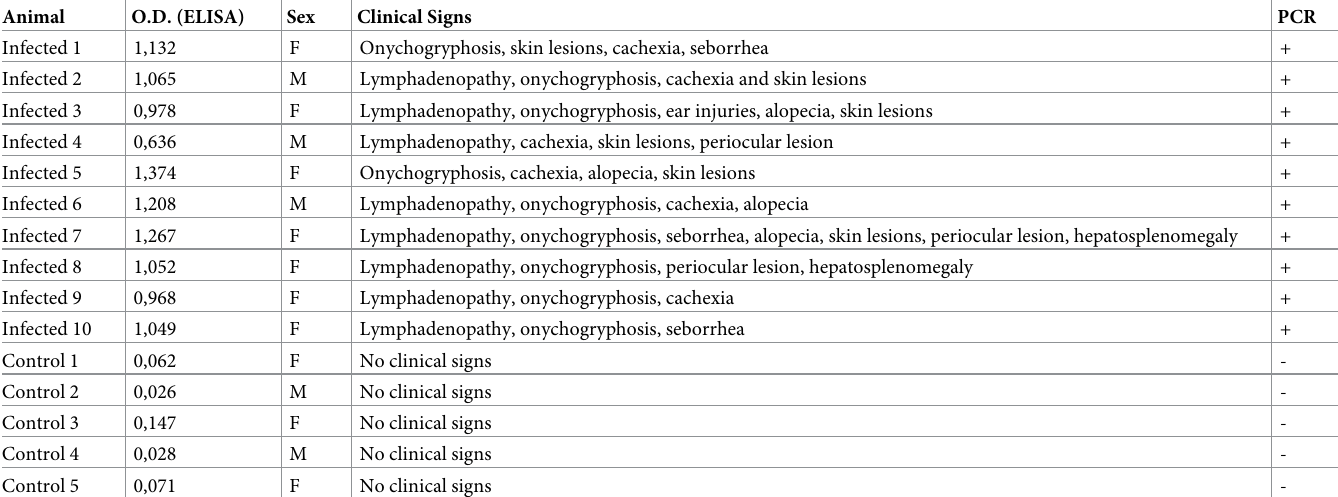
Table 1. Screening of dogs. Optical density on ELISA and clinical signs of CanL and control groups. Animal O.D.